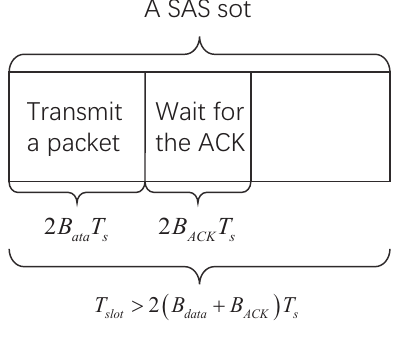
Figure 5. An example of SAS